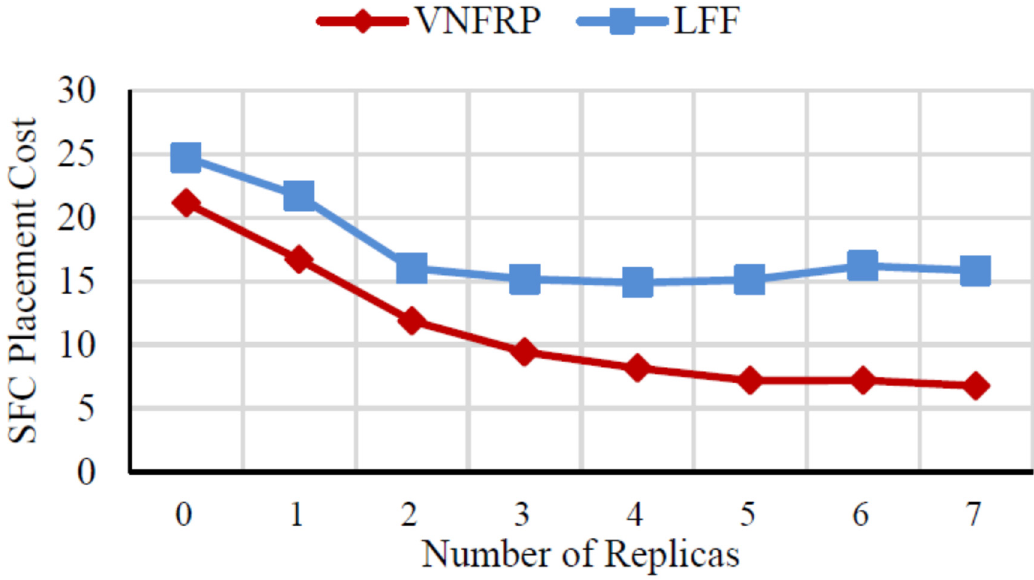
Figure 9. Service function chain (SFC) placement cost when adopting the VNFRP algorithm and the corresponding values when adopting the LFF strategy.